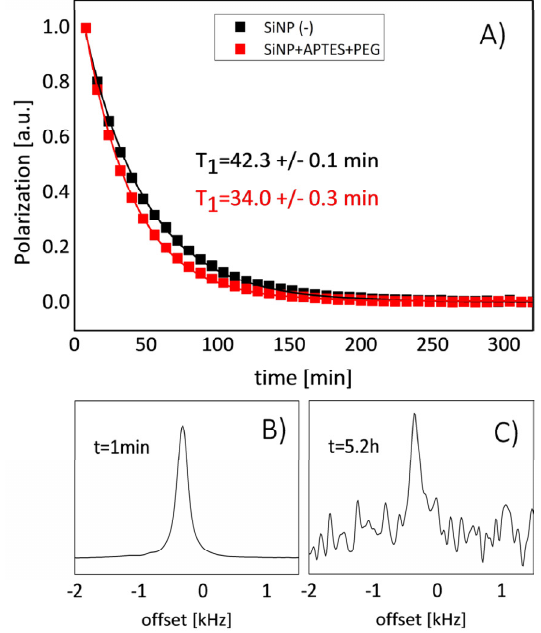
Figure 19. ( A ) Comparison of T 1 relaxation between pure (black) and PEG functionalized (red) silicon NPs. The Fourier-transformed free induction decay signal acquired at t = 1 min ( B ) and t = 5.2 h ( C ) at room temperature using a 9.4 T imaging system. (Reprinted from Reference [52], © (2017),